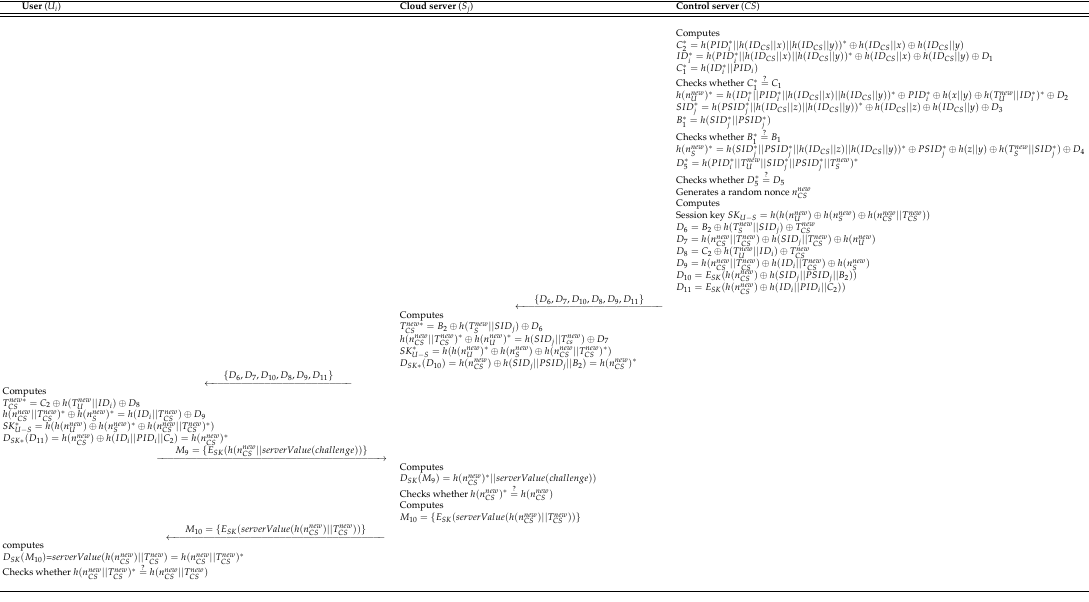
Figure 4. Authentication process of the Pelaez et al.’s scheme